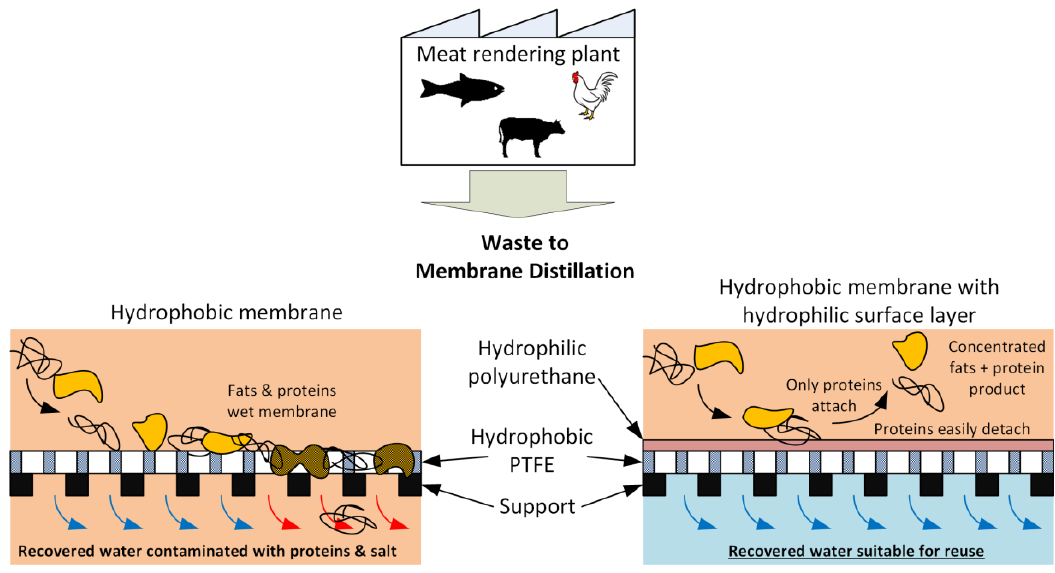
Figure 9. Concept of meat rendering stick water effluent fouling on the hydrophobic PTFE membrane and the fouling resistance of the hydrophilic coated PU-PTFE membrane based on results from this study.